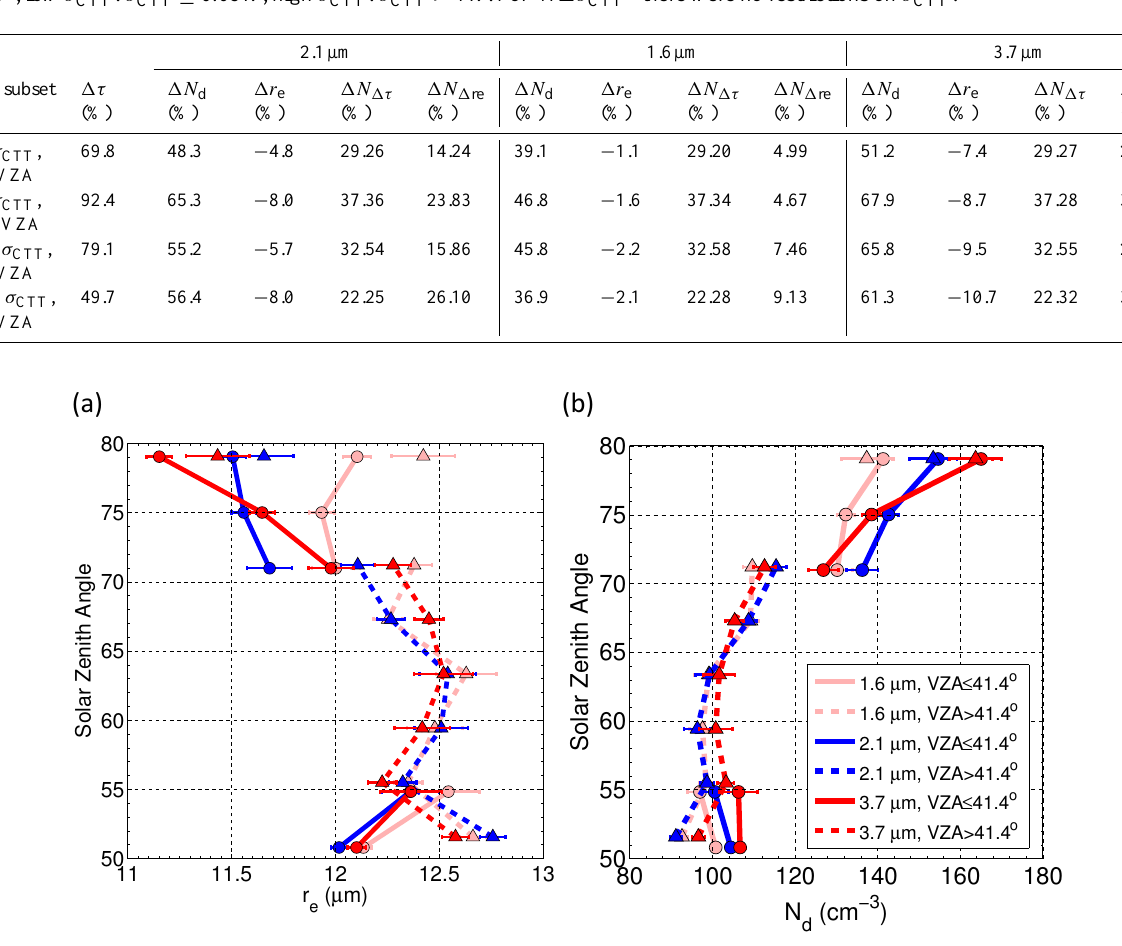
Table 1. Changes in various quantities between the lowest and highest θ 0 bins (high minus low). 1N 1τ and 1N 1 re are the changes in N d from paired τ and r e samples constructed using Latin Hypercube Sampling (see Appendix D) for, respectively, separate changes in τ and r e (see text). Four different data subsets are shown for which various restrictions have been applied: Low VZA: VZA ≤ 41 . 4 ◦ ; high VZA: VZA